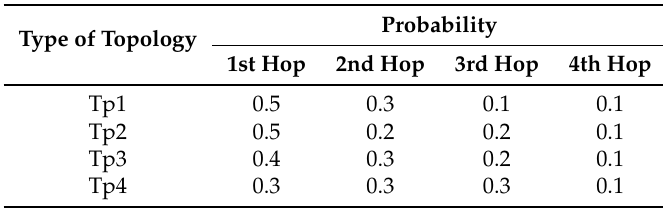
Table 2. The proportions of different types of